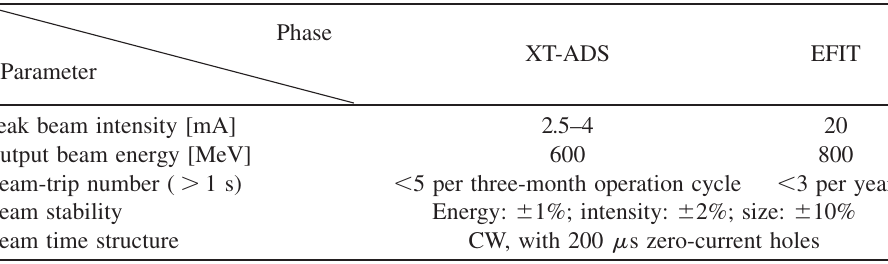
TABLE I. Specifications of the required proton beams for XT-ADS and EFIT [3].